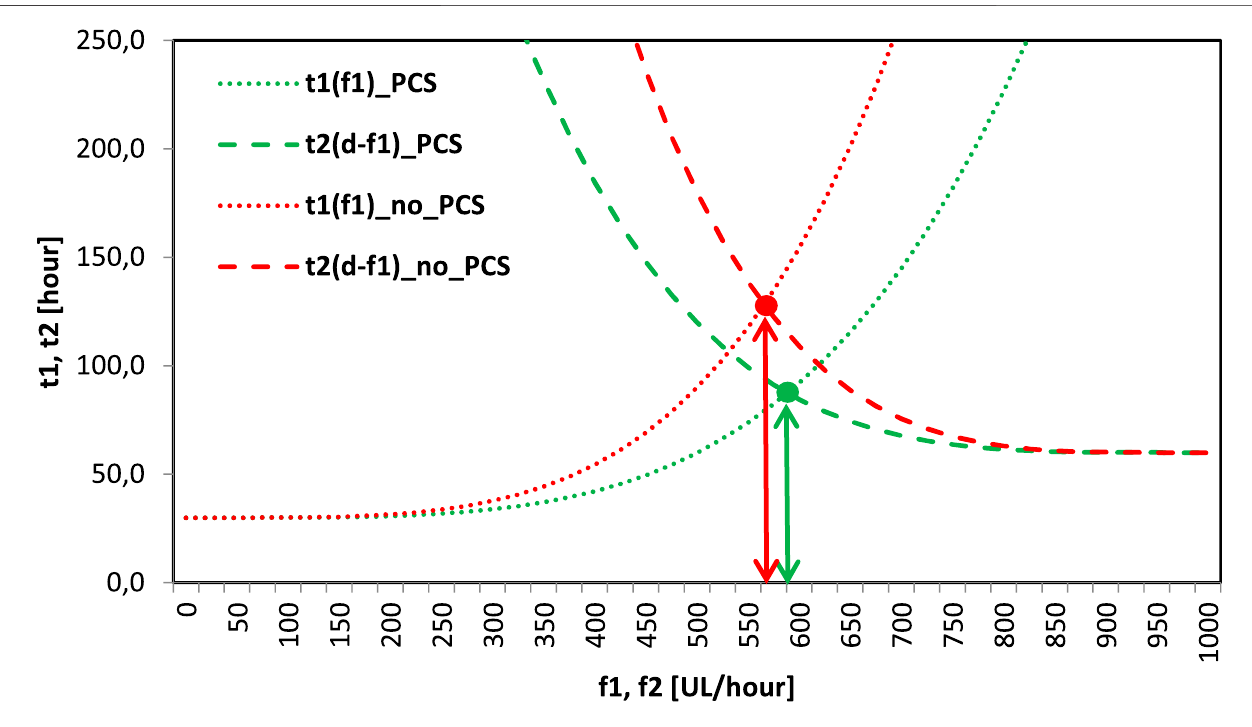
FIGURE 1 | Cost functions of ports 1 and 2 with and without PCS ( Eq. 4.1 ).